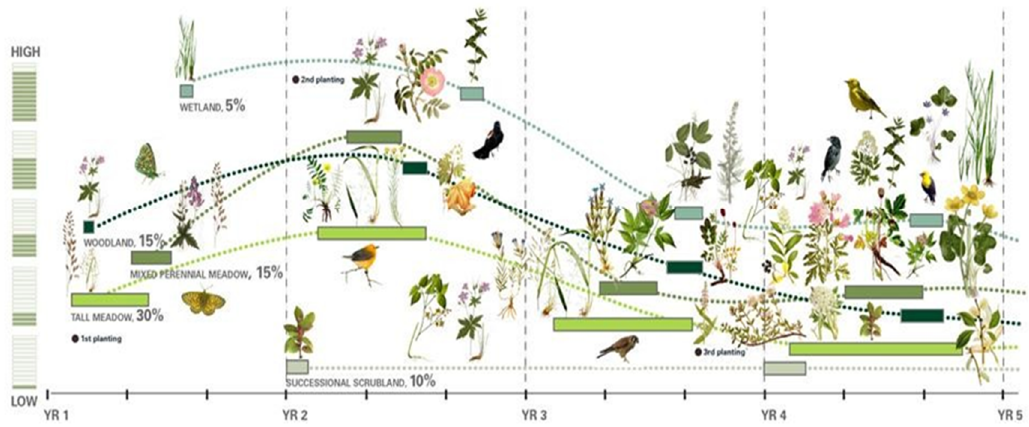
Figure 6. The emergence of a wild and biodiverse ecological system over the time. Reprinted from ref. [50].